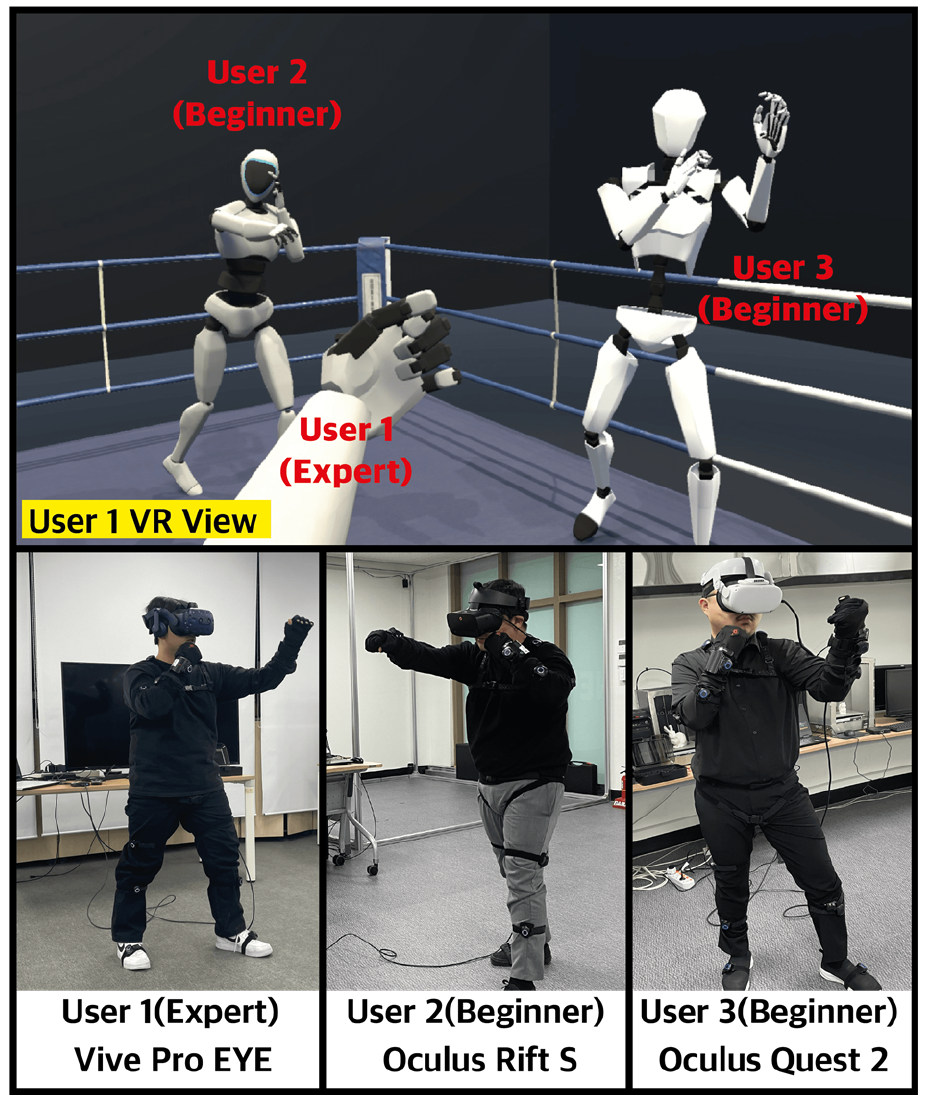
Figure 12. Multi-remote collaboration Test.